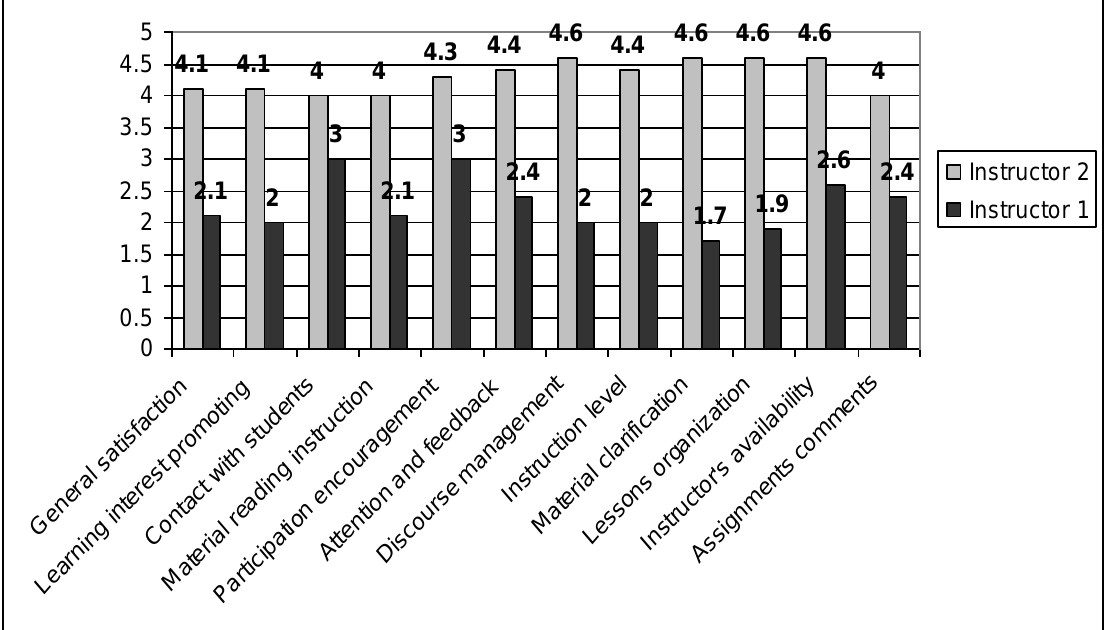
Figure 1 . Students‟ evaluations of